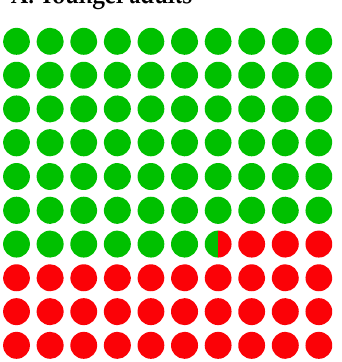
Figure 5. Overview of consumers’ ( n = 67) consumption habits relating to protein-fortified products by age (( A ) younger adults n = 39 and ( B ) older adults n = 28). “Yes” denoted consumers consumed protein fortified products: daily (4.5%), two-to-six times a week (4.5%), weekly (3.0%), one-to-three times a month (12%) and monthly (21%) and “No” highlighted never (55%) consumed protein-fortified products. Data expressed as % with each coloured circle demonstrates 1.0%.